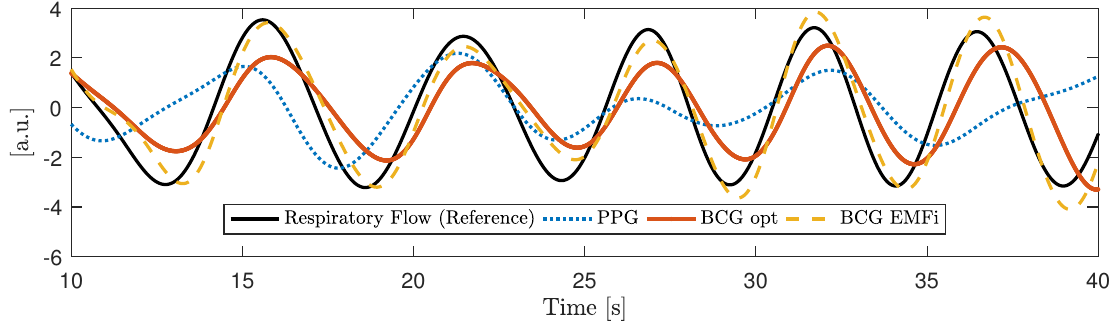
Figure 8. Excerpt of the measurement presented in Figure 7 to highlight the respiratory component. All signals were bandpass filtered with a passband of 0.1 to 0.3Hz. The PPG signal was inverted to better align its phases for visual comparison.